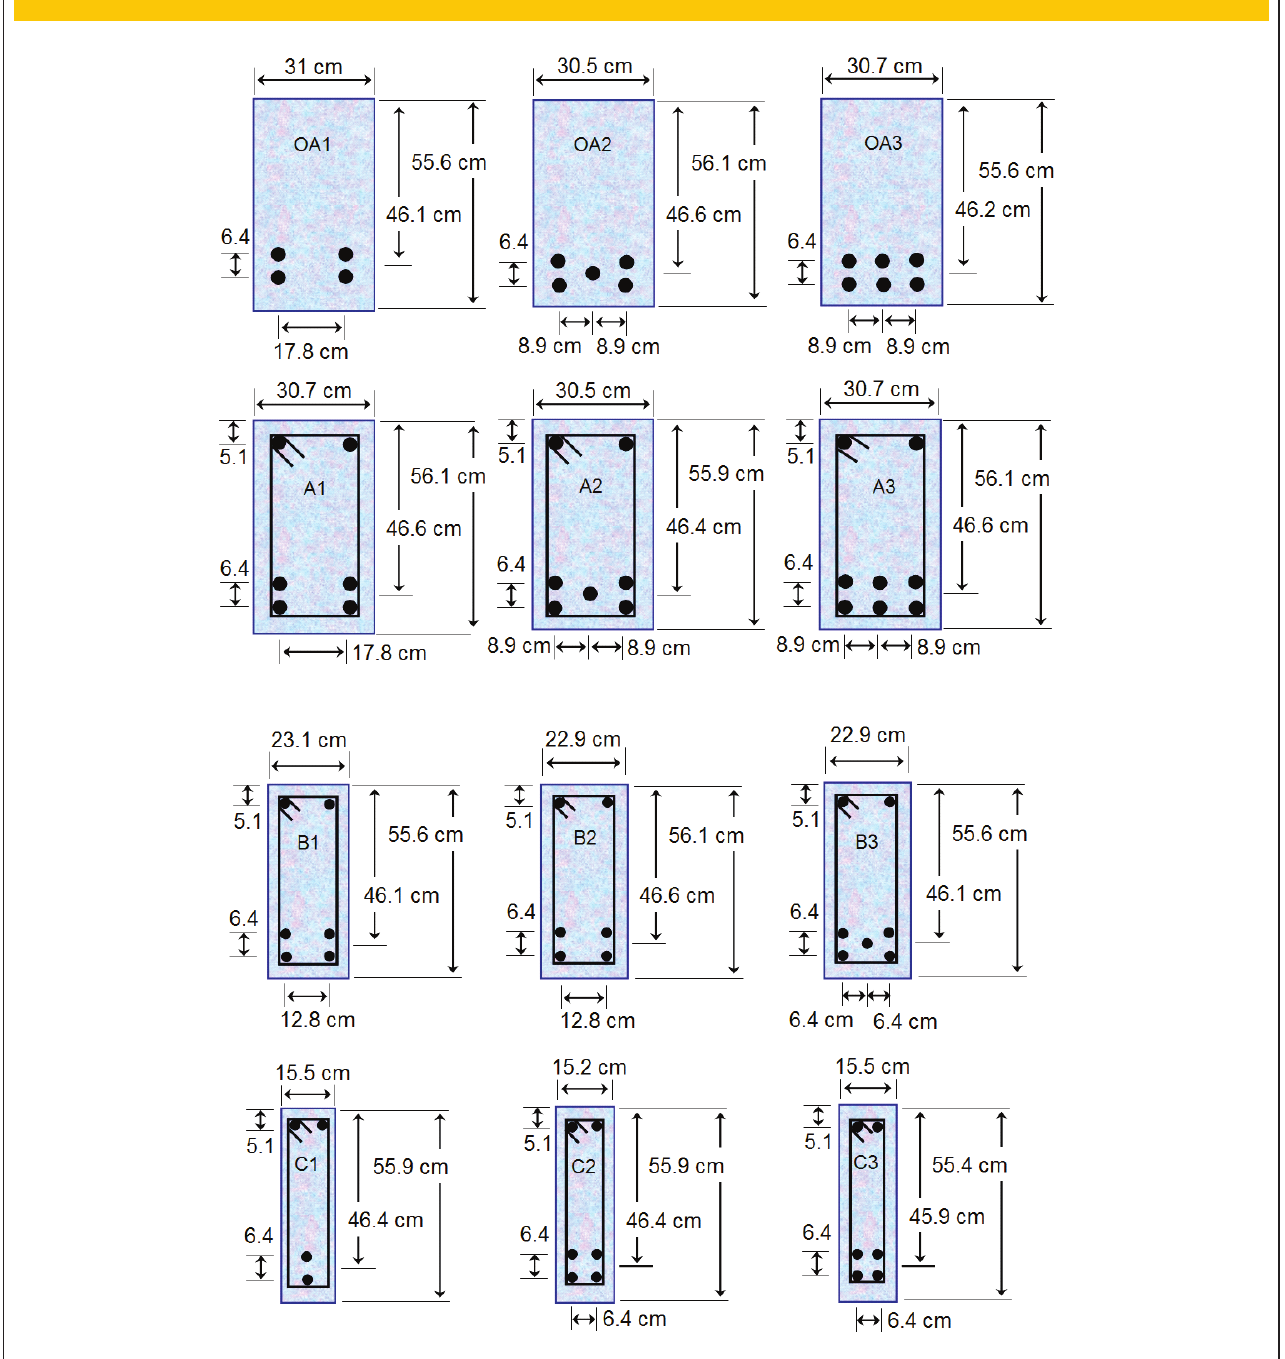
Figure 7 – Beams' cross sections for the tests by Bresler and Scordelis